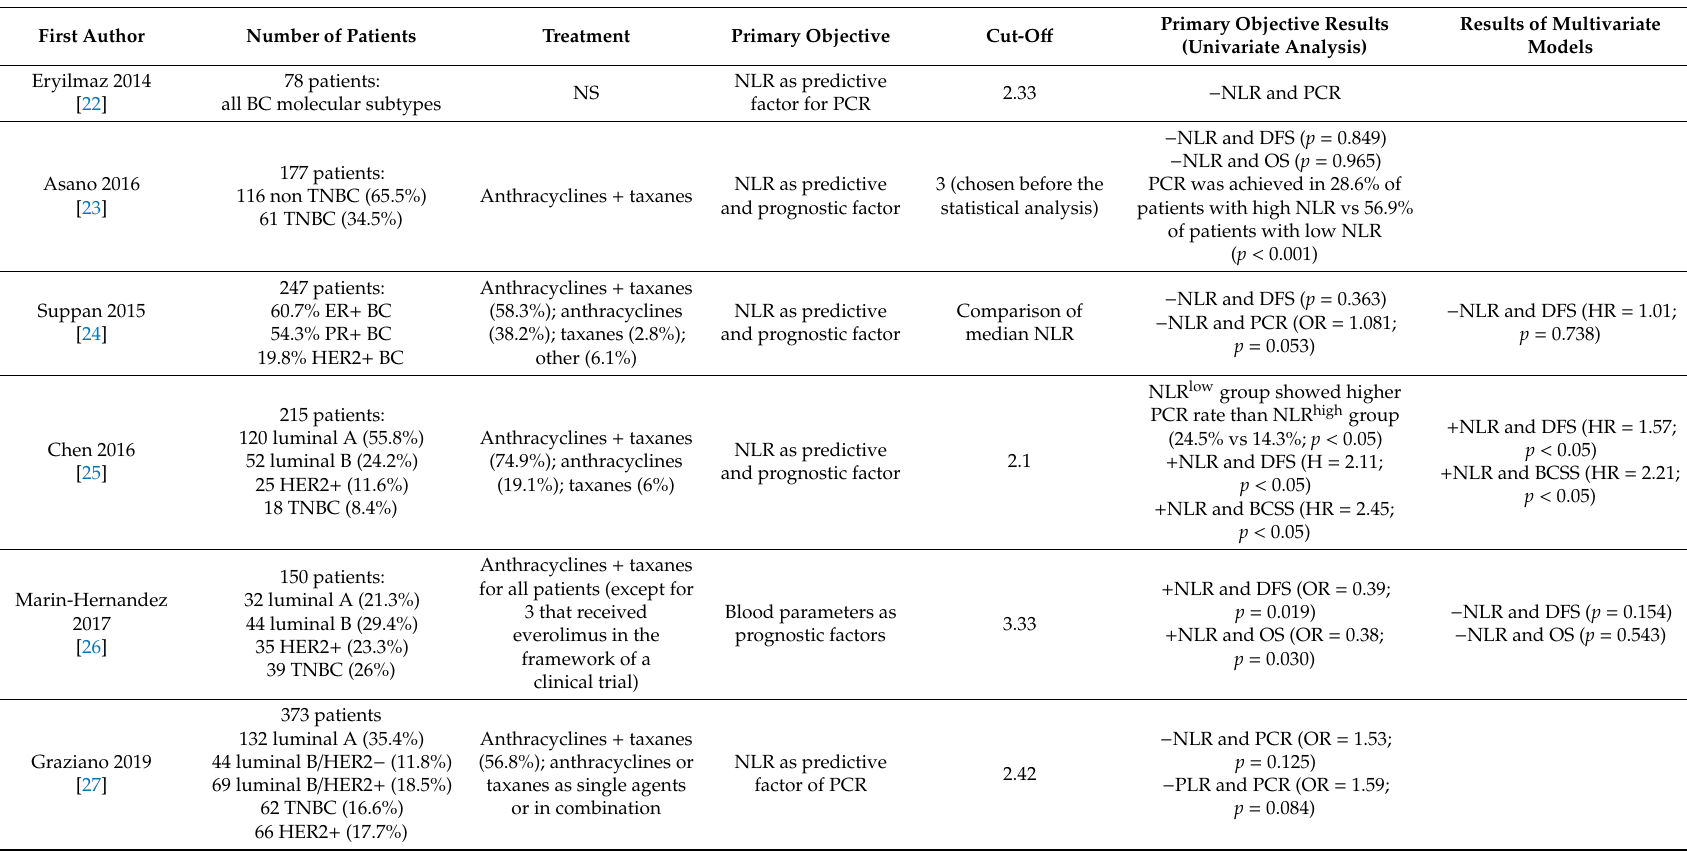
Table 1. Articles including data on neutrophil to lymphocyte ratio (NLR) as predictive and prognostic factor in patients with early breast cancer (BC) receiving neo-adjuvant